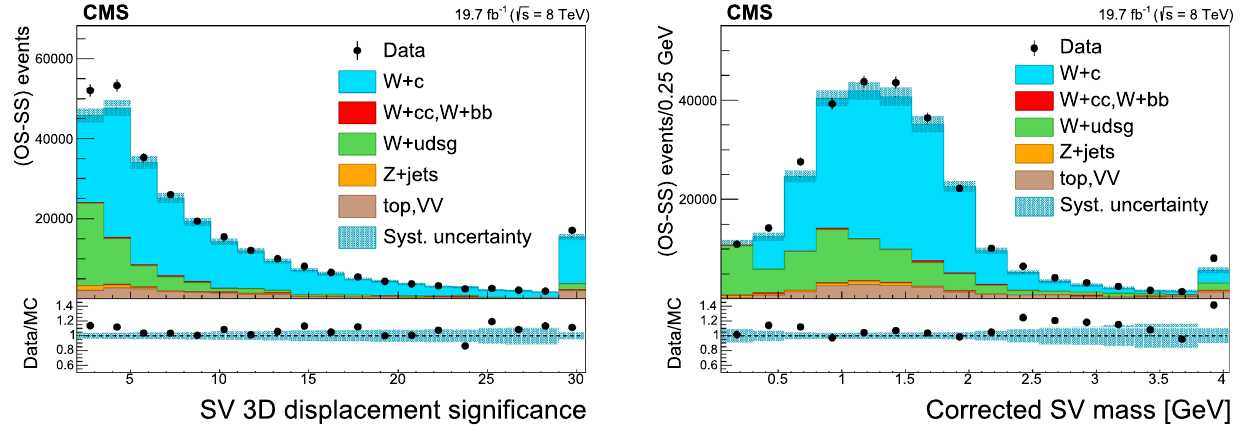
Fig. 3 Distributions after OS–SS subtraction of the secondary-vertex displacement significance (left) and corrected secondary-vertex mass (right). For each distribution all selection requirements are applied except the one on the displayed variable. The last bin of each plot includes all events beyond the bin. The contributions from all processes are estimated with the simulated samples. Vertical bars on data points